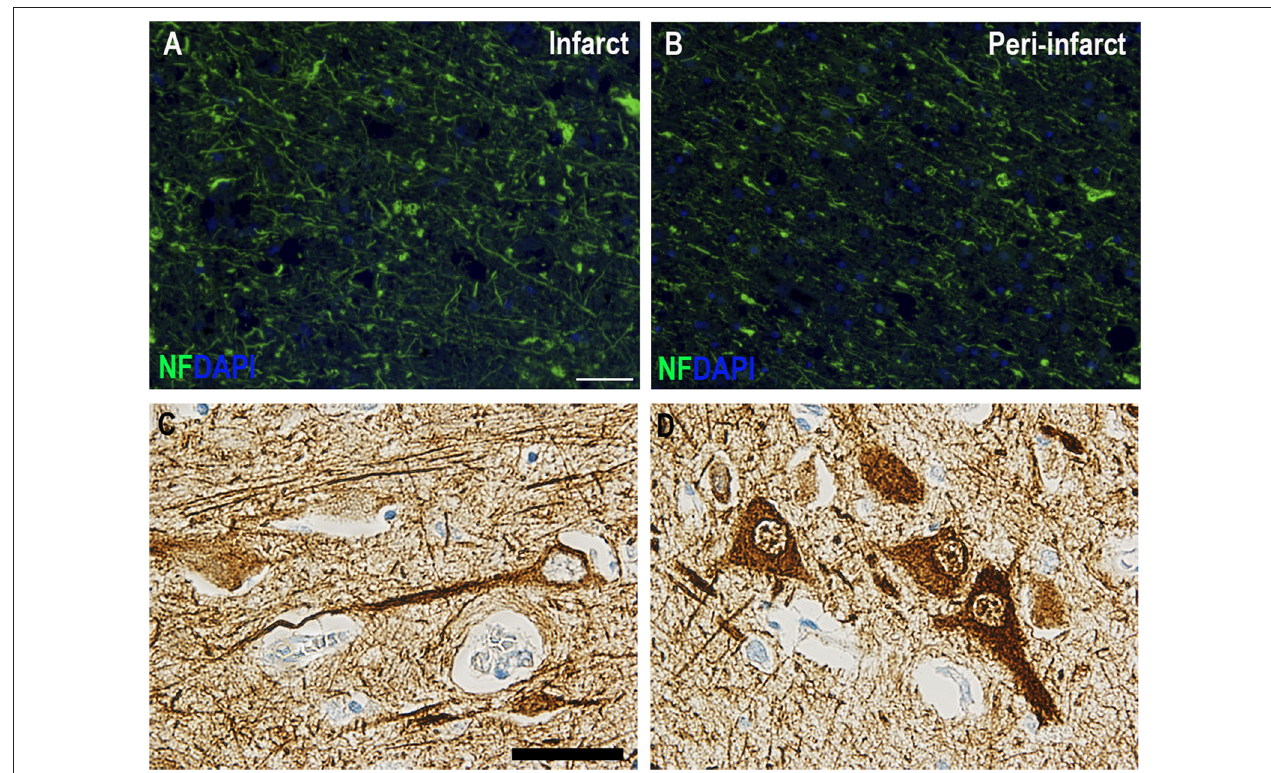
FIGURE 1 | Immunohistochemical staining of neurofilament-positive neurons in postmortem human ischemic brain tissue. (A,B) Neurofilament immunofluorescent staining in a > 7-day-old right parietal lobe infarct demonstrating increased NF staining in the infarct (A) compared to the peri-infarct (B) . Scale bar: 100 µ m. (C,D) High magnifications of neurofilament-positive neurons in paraffin sections from a 3–7-day-old left temporal lobe infarct. Scale bar: 40 µ m.